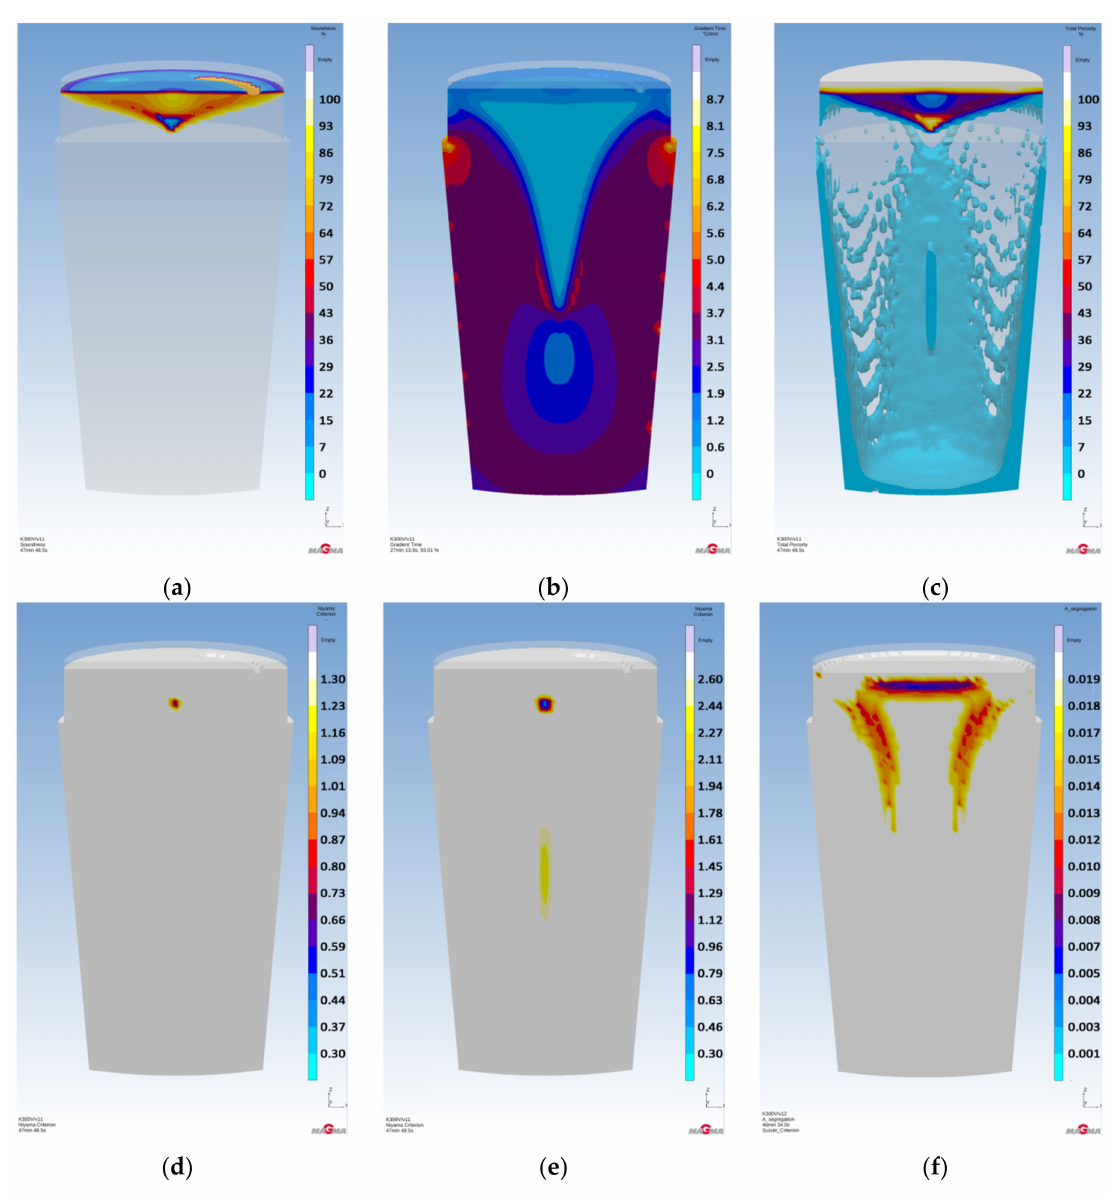
Figure 10. The results of criteria: ( a ) Soundness %; ( b ) Gradient Time 27 min 13.9 s; ( c ) Total Porosity %; ( d ) Niyama 0.3–1.3 K 1/2 s 1/2 mm − 1 ; ( e ) Niyama 0.3–2.6 K 1/2 s 1/2 mm − 1 ; ( f ) A-segregation (Suzuki criterion) 0.0–0.010 K s − 1 ( µ m s − 1 ) 1.1 . Element Segregation, PDAS and SDAS in 34CrNiMo6 Steel Ingot